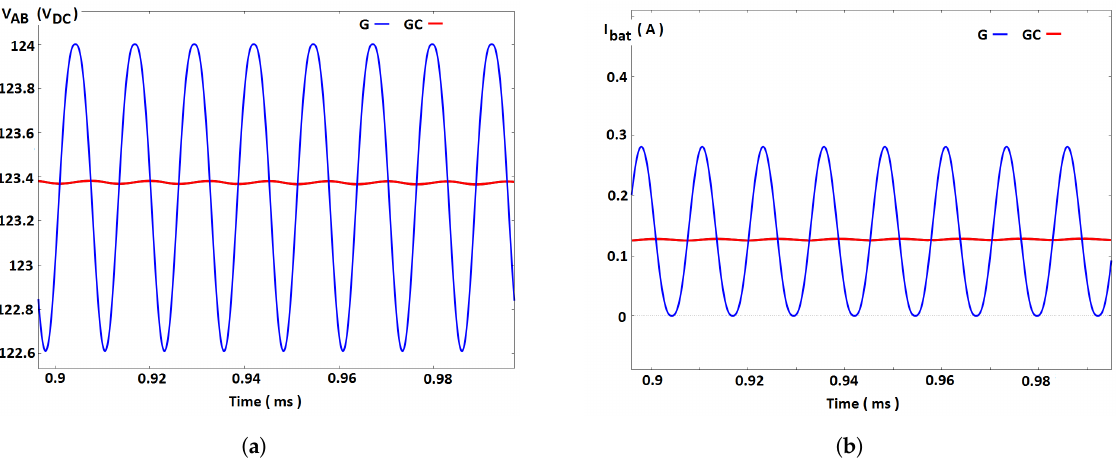
Figure 17. Diminishing of the ripples due to the capacitor. ( a ) LED voltage ripple. ( b ) LED current